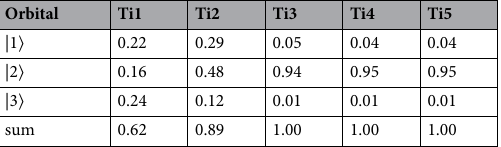
) occupations within each TiO 2 layer of δ -doped SmTiO 3 2 g